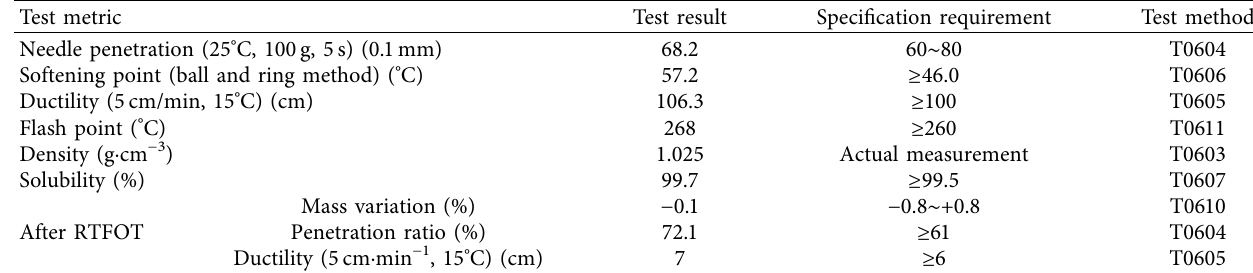
Table 1: Technical indicators of 70 matrix asphalt.